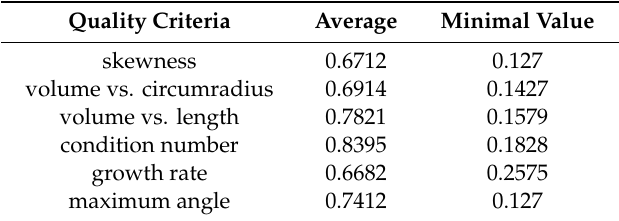
Table A1. Specific values to evaluate the mesh